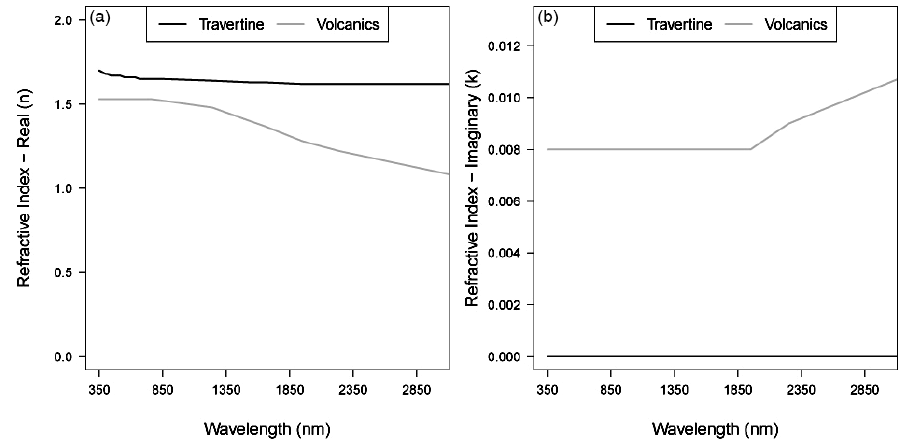
Figure 6. Real (a) and imaginary (b) part of refractive index of the volcanics and travertine PM 10 dust.